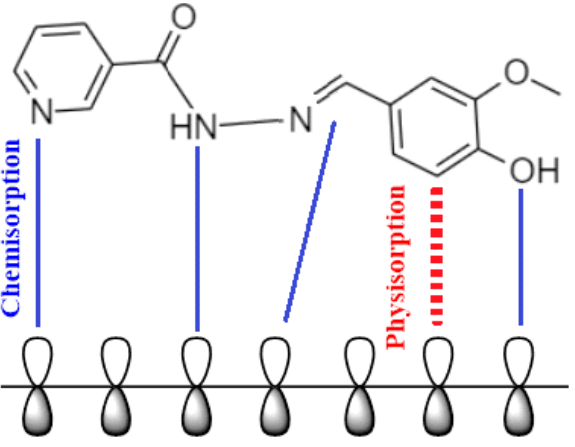
Figure 12. The proposed mechanism of corrosion inhibition of mild steel in 1 M HCl.